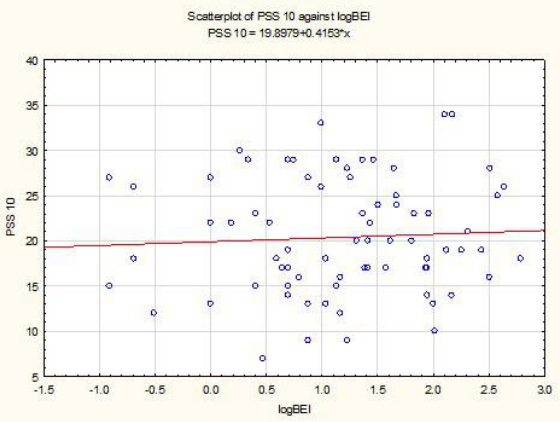
Figure 1. Relationship between Bruxism Episodes Index (BEI) and Perceived Stress Scale-10 (PSS-10) values.